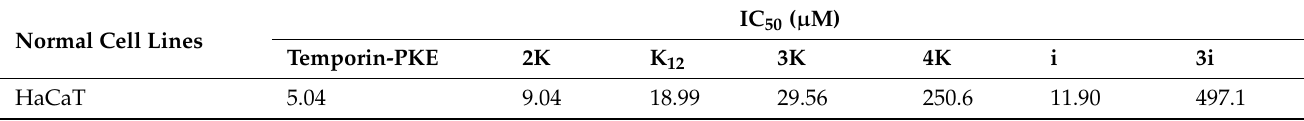
Table 5. The IC 50 values of temporin-PKE and its analogues against HaCaT cells.